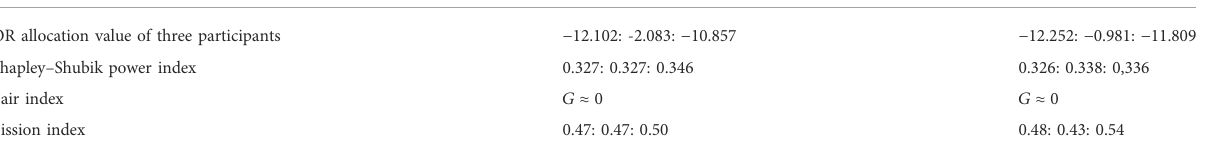
TABLE 7 Contrast before and after Shapley revisions. Contrast